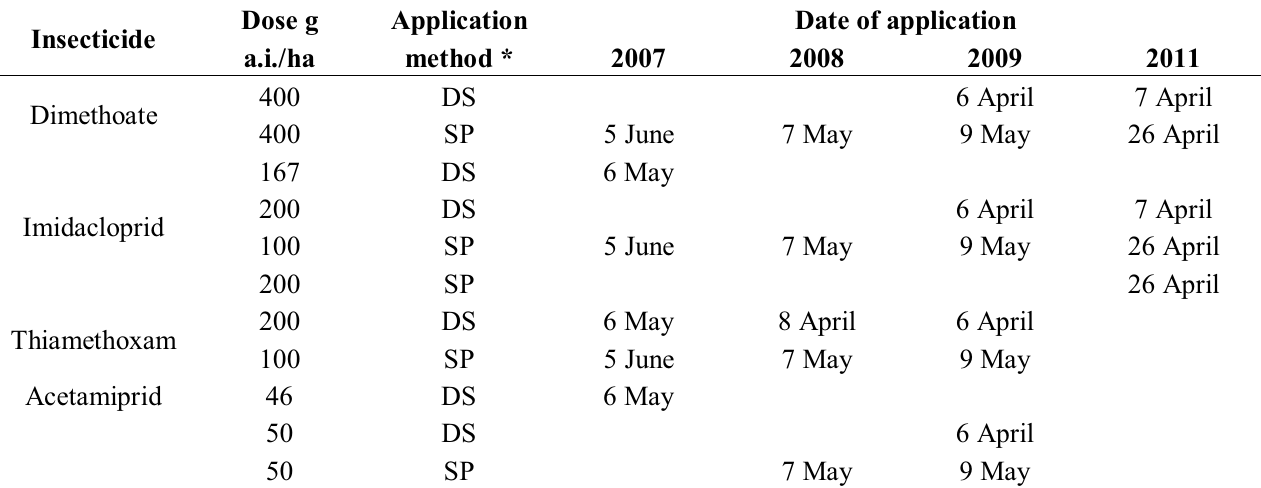
Table 2. Insecticides tested, rates and methods of application, and dates of application in each